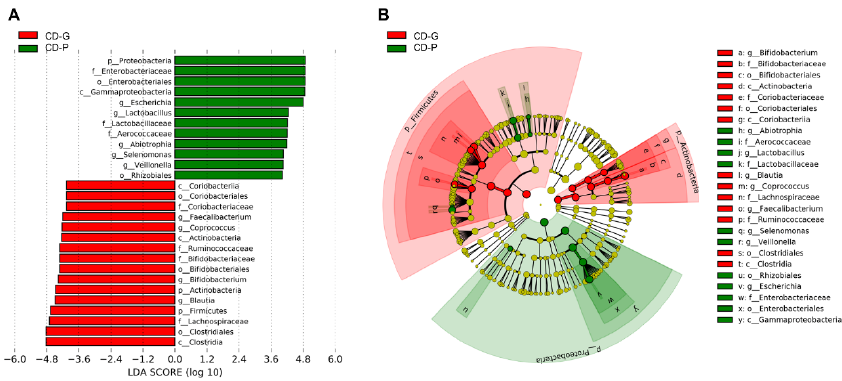
Figure 4. Differentially abundant bacterial taxa between good prognosis (CD-G) and poor prognosis (CD-P) groups in Crohn’s disease. ( A ) A forest plot showing the LDA score indicating significant differences in the bacterial taxa between the CD-G (red) and CD-P (green) groups (LDA score >4.0; p < 0.05). ( B ) Cladogram generated using the LEfSe method, indicating the phylogenetic distribution of microbes associated with the CD-G and CD-P groups. CD-G = good prognosis group; CD-P = poor prognosis group; LDA = linear discriminant analysis.